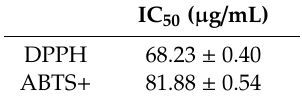
Table 5. In vitro ECH (extract from Carthamus tinctorius L. honey) free radical scavenging